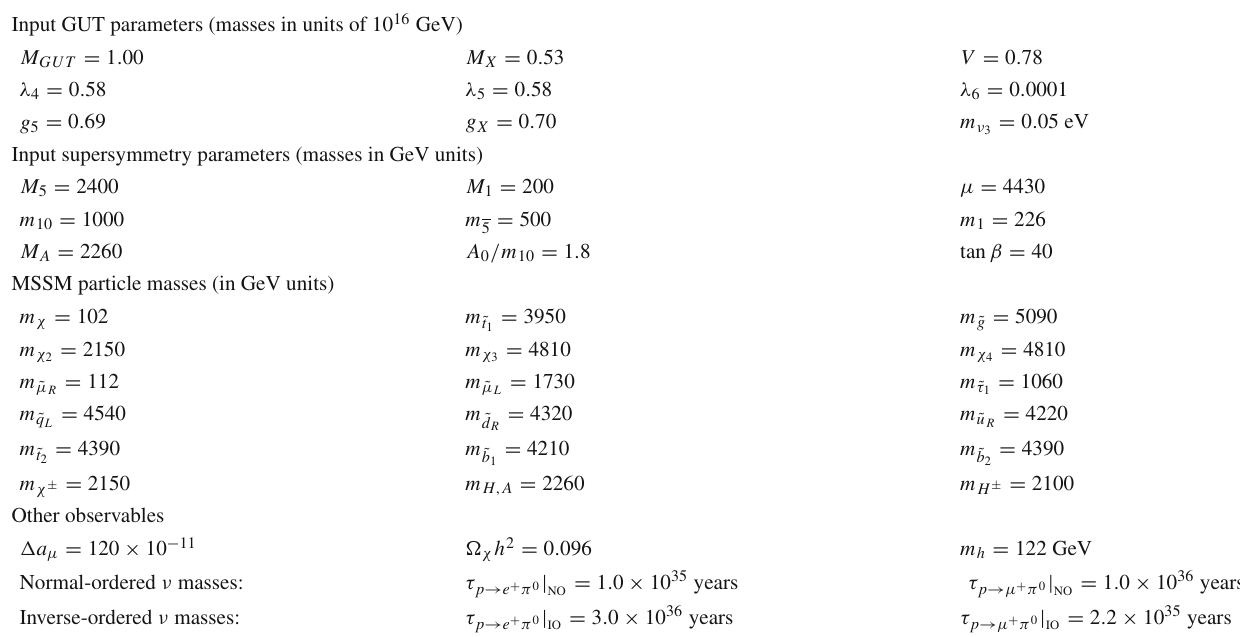
a lifetime for p → e + π 0 within reach of the Hyper-Kamiokande exper- iment if neutrino masses are normal-ordered. This point corresponds to the star in the lower right panel of Fig. 11